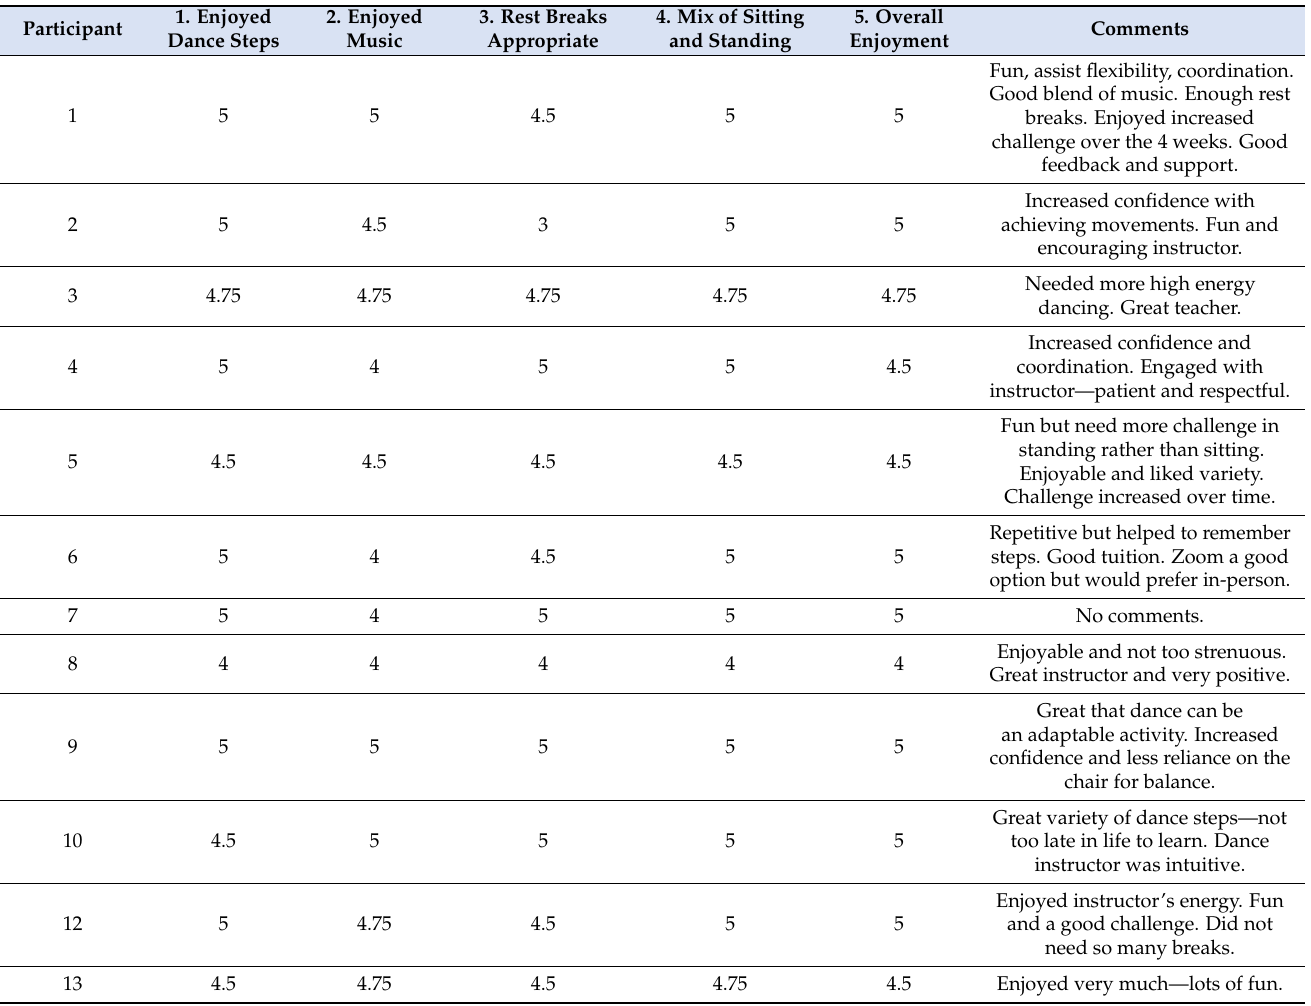
Table 5. Dancer post class surveys (score per question 1 (strongly disagree)—5 (strongly agree), mean total for each